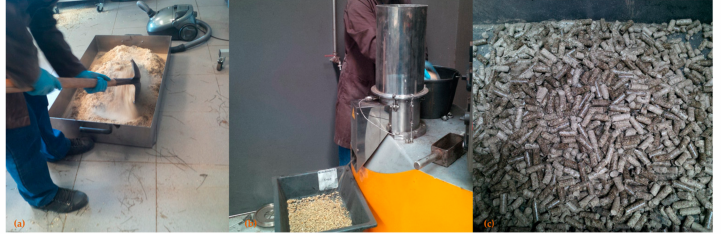
Figure 2. Different stages of the pelletization process of C. striatus biomass. ( a ) Homogenization and correction of humidity; ( b ) pellet production; ( c ) final